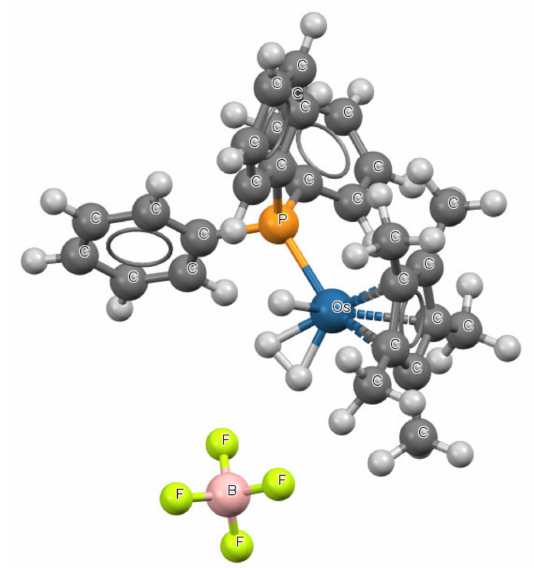
Figure 1. The fragment of the crystal structure of ( η 5 -pentamethyl-cyclopentadienyl)-(dihydrogen)- dihydrido-triphenylphosphine-osmium (iv) tetrafluoroborate (NOLJIH refcode). Small grey circles correspond to